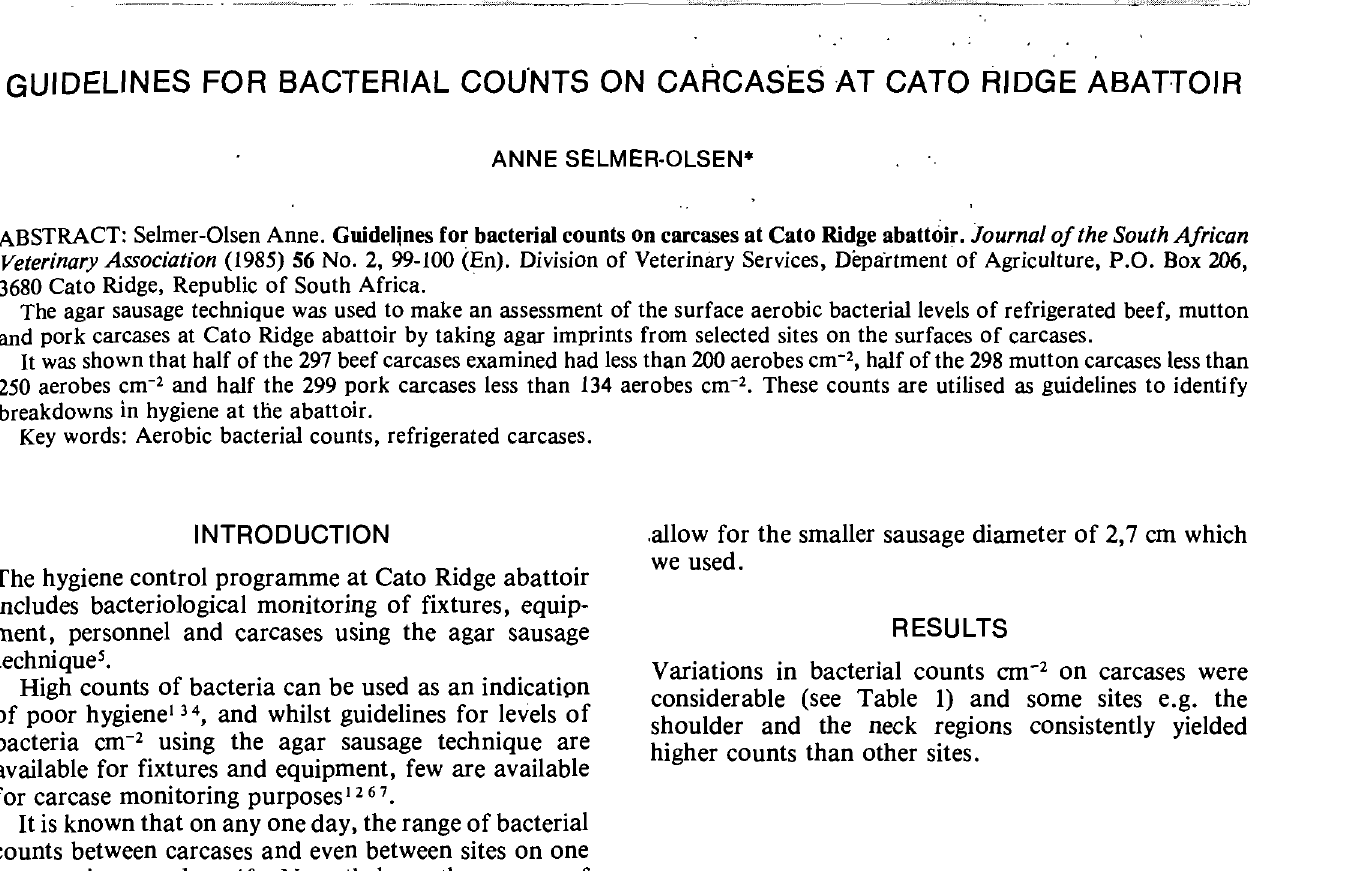
Table 1: RANGE OF CARCASE SURFACE BACTERIAL COUNTS cm- 2